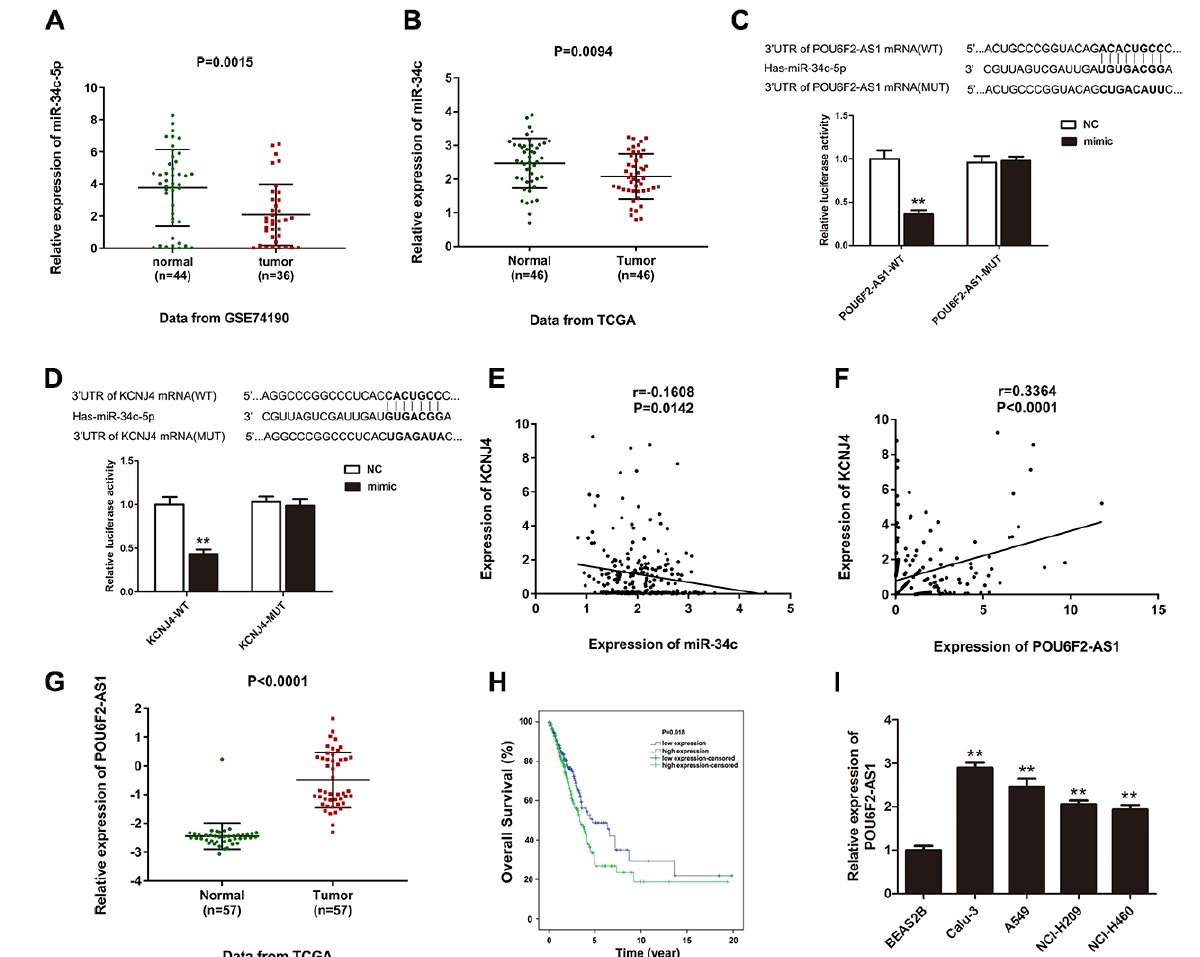
Figure 1 – Correlations between miR-34c-5p and POU6F2-AS1 or KCNJ4 in LADC and relative expression level of POU6F2-AS1 in LADC tissues and cell lines, and its prognostic significance. Relative expression level of miR-34c-5p in LADC tissues and normal tissues based on (A) GEO dataset (44 normal tissues and 36 LADC tissue samples) and (B) TCGA database (46 pairs of LADC tissues and normal samples). Dual-luciferase reporter assays were performed to test the relevance of miR-34c-5p and (C) POU6F2-AS1 and (D) KCNJ4. Pearson’s correlation analysis was used to detect the relationship between KCNJ4 and (E) miR-34c-5p or (F) POU6F2-AS1. (G) Relative expression level of POU6F2-AS1 was determined in LADC tissues (n = 57) compared with adjacent normal tissues (n = 57), P < 0.0001. (H) Overall survival curve of LADC patients with high and low POU6F2-AS1 expression levels, P = 0.018. (I) Relative expression level of POU6F2-AS1 in four LADC cell lines and one human normal lung epithelial cell line BEAS2B, **P <